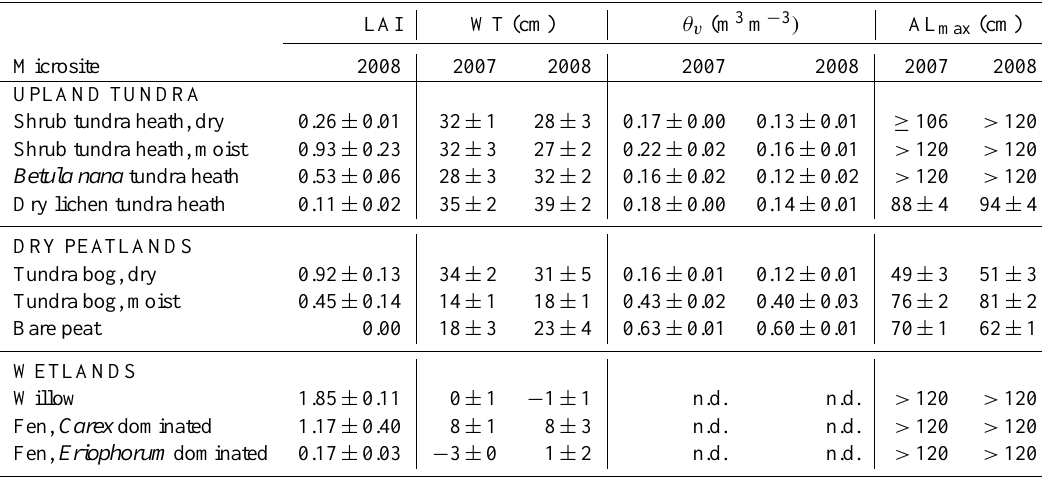
Table 4. Characteristics of the microsites measured with chamber technique: leaf area index (LAI), water table level (WT), soil moisture ( θ v ) and maximum active layer depth (AL max ) . Data for LAI and θ v are growing season means ± standard error, whereas a range is shown for AL max ( n = 3).